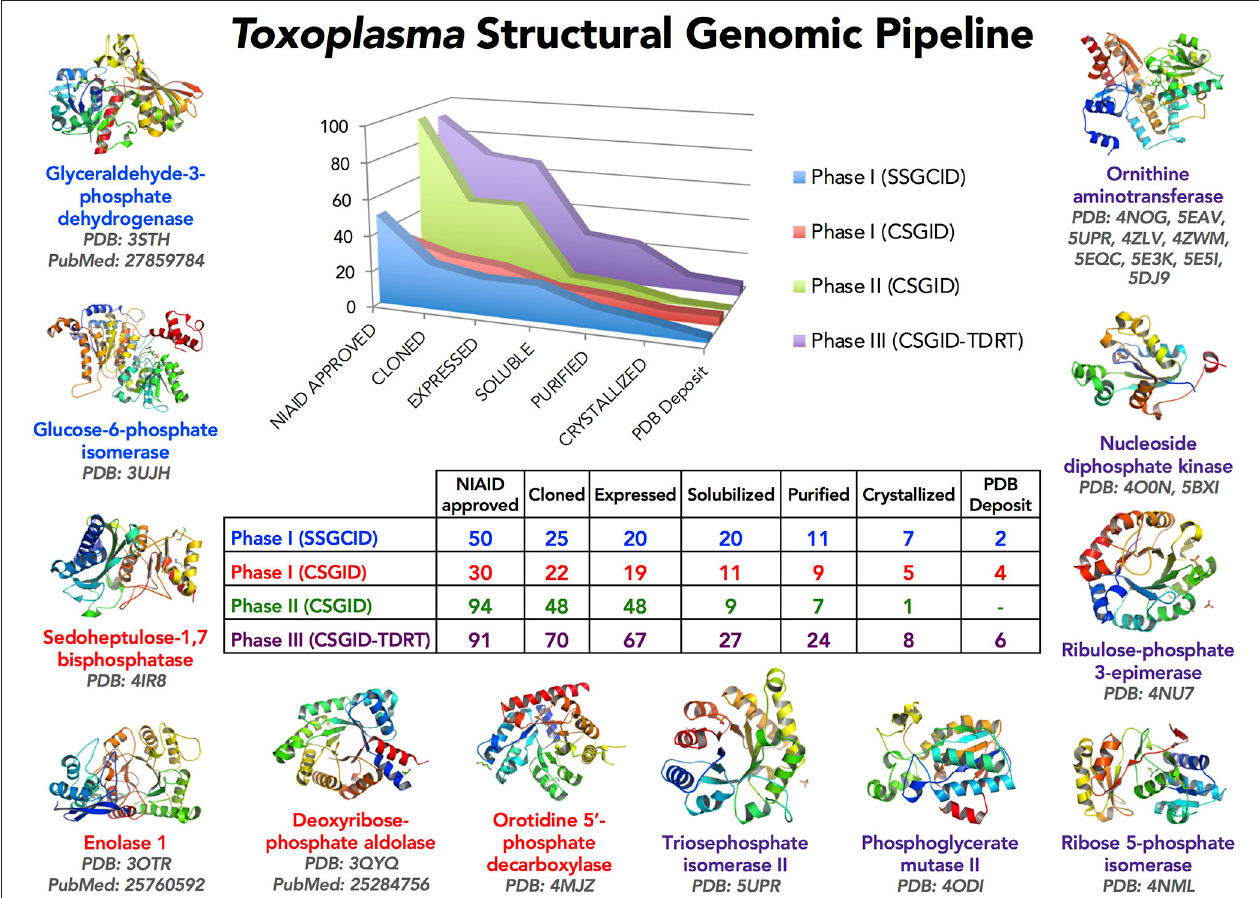
FIGURE 1 | The Toxoplasma Structural Genomics Pipeline identified promising targets with good predicted druggability (Phase III) and outstanding interest to the Toxoplasma research community (Phase I, II). Toxoplasma proteins were selected for Phase I from published work up to 2009 and communicated with the research laboratories. Phase II included proteins from published and unpublished studies suggested by international researchers at the end of 2011. Phase III candidates were selected from the Tropical Diseases Research Database (TDRT). Proteins judged very unlikely to crystallize based on analysis by XtalPred were eliminated (Slabinski et al., 2007). Several structures solved have already been described (Ruan et al., 2015; Tonkin et al., 2015; Dubey et al., 2017). This crystallography pipeline remains available for production and solution of structures of proteins for scientists in the Toxoplasma research